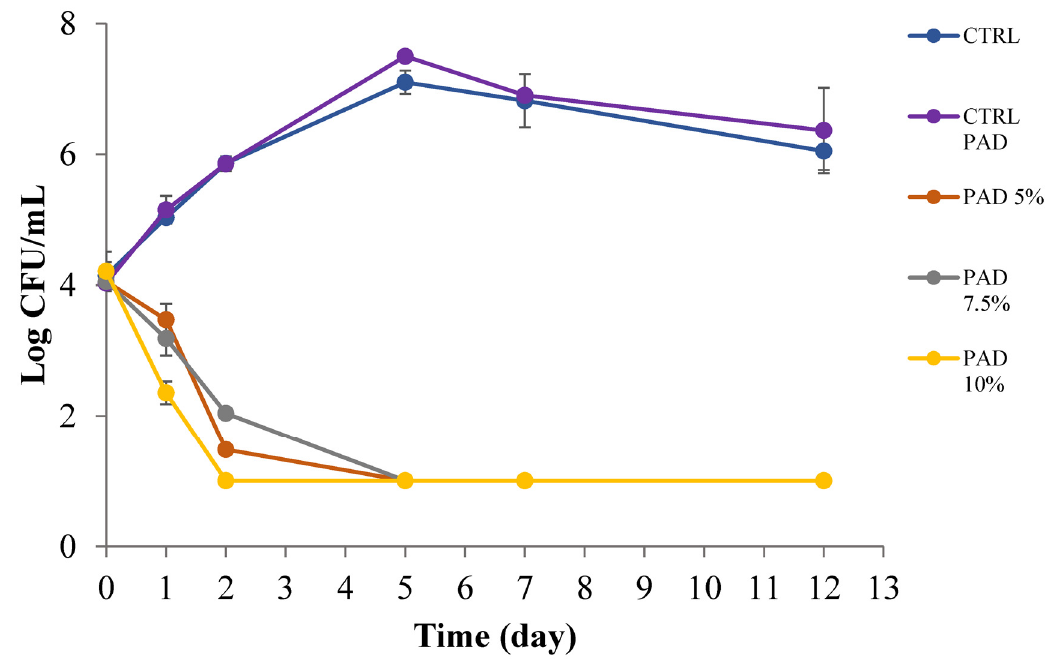
Figure 7. A. acidoterrestris in apple juice with and without pads at 0, 5, 7.5 and 10% ( w / v ).